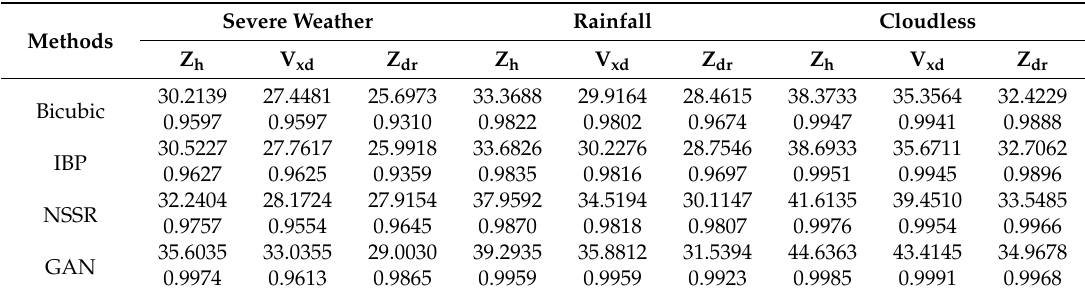
Table 4. Average PSNR (dB) and SSIM results of the reconstructed echo of five groups of level-II data products of XPRAD radar. ( ×